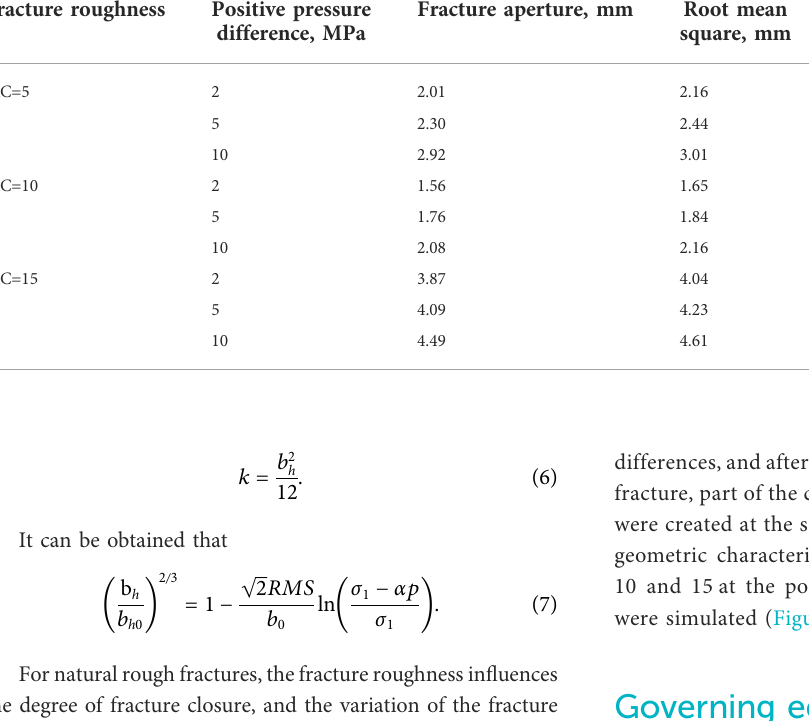
TABLE 1 Geometric characteristics of propagating fractures. Fracture